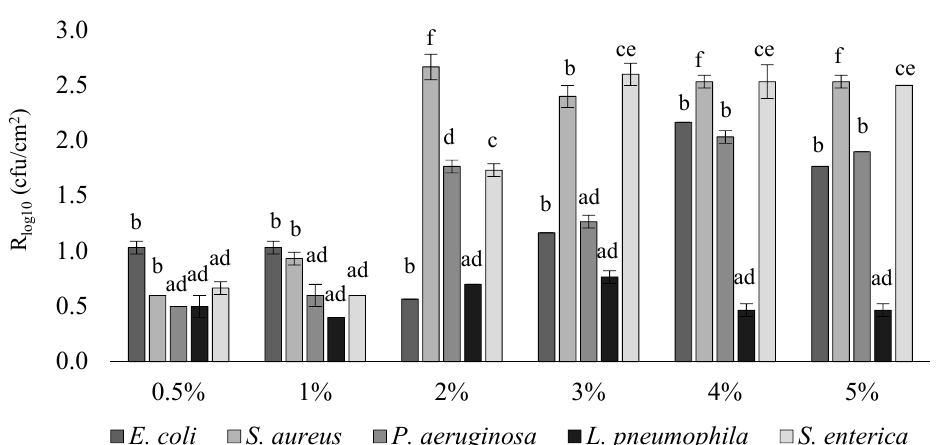
Figure 1. Antimicrobial activity (R) values of samples containing the biocide at a concentration